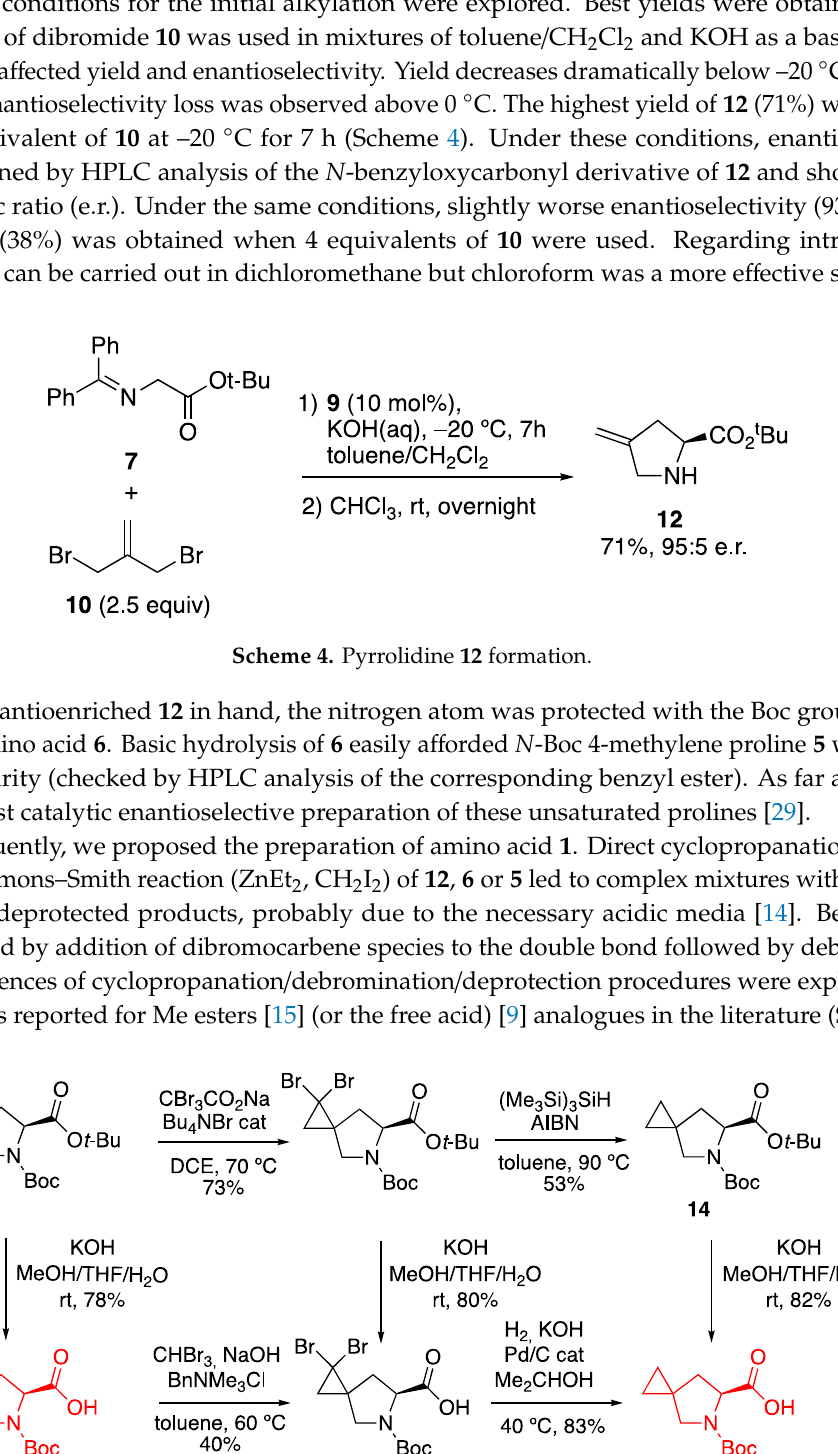
Figure 2. Structure of byproduct